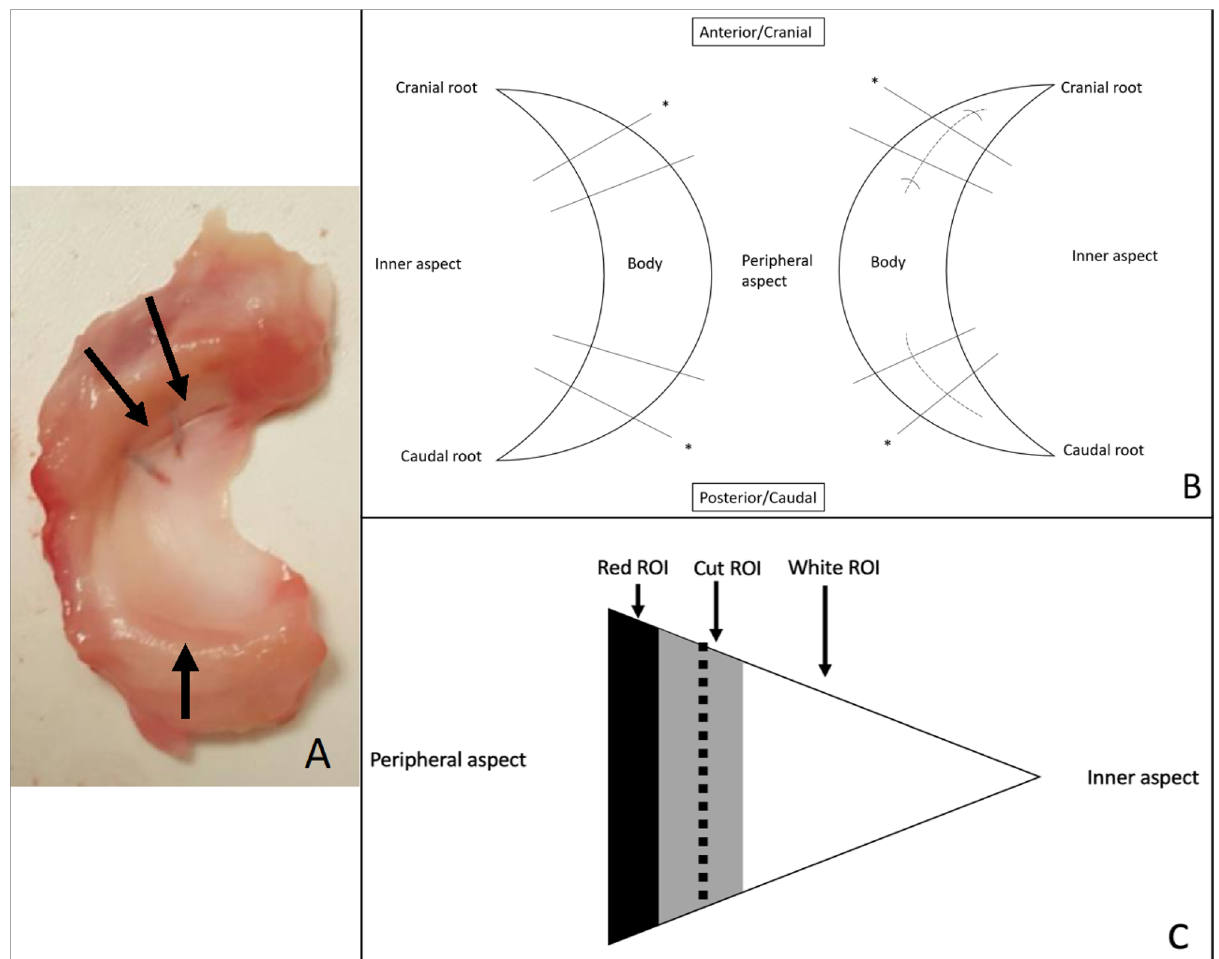
Figure 1. ( A ) Excised menisci from the right stifle. Operated meniscus is shown with two arrows pointing to the sutured tears on the cranial aspect (deep/inferior sutures not visible). A singular arrow shows the location of the non-repaired tear on the caudal aspect. This arrow also points in the direction of the main magnetic field (B 0 ) for the MRI experiments. ( B ) Location of medial meniscal tear incisions shown with dotted lines. Cranial tears were sutured. Caudal tears were left unrepaired. Straight black lines (n = 8) represent approximate MRI imaging planes. Black lines with asterisk represent sectioning locations for histology (n = 4 per goat). Tissue between the straight black lines (3 mm in width circumferentially) was removed for biomechanical testing in the radial direction. The medial meniscus depicted on the left is the contralateral control. ( C ) Cross section of MRI imaging plane. Meniscal tear shown with dotted line. MRI regions of interest are shown as black (Red ROI), grey (Cut ROI), and white (White